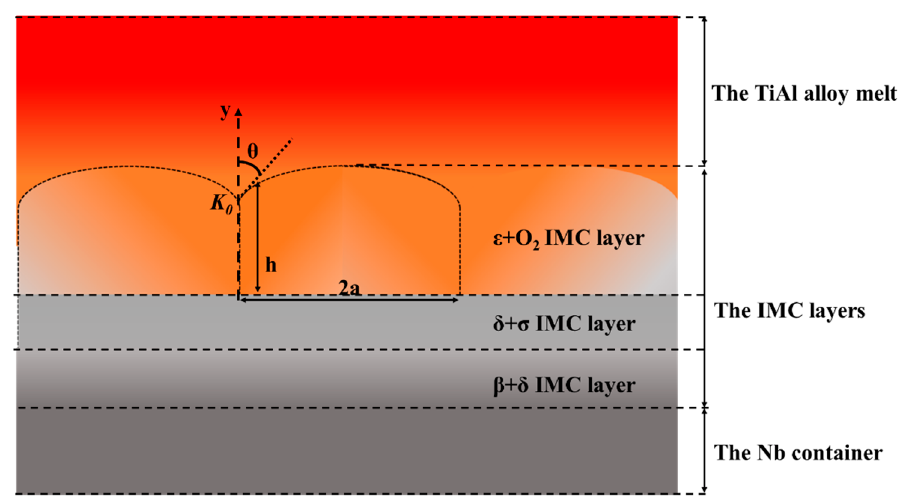
incident and consistent with other studies [55,56]. The macroscopic behavior is that the